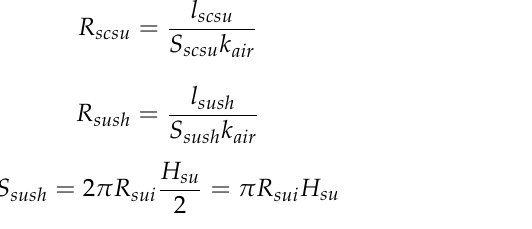
Figure 7. Stator: ( a ) segmented stator core; ( b ) stator core and cages.